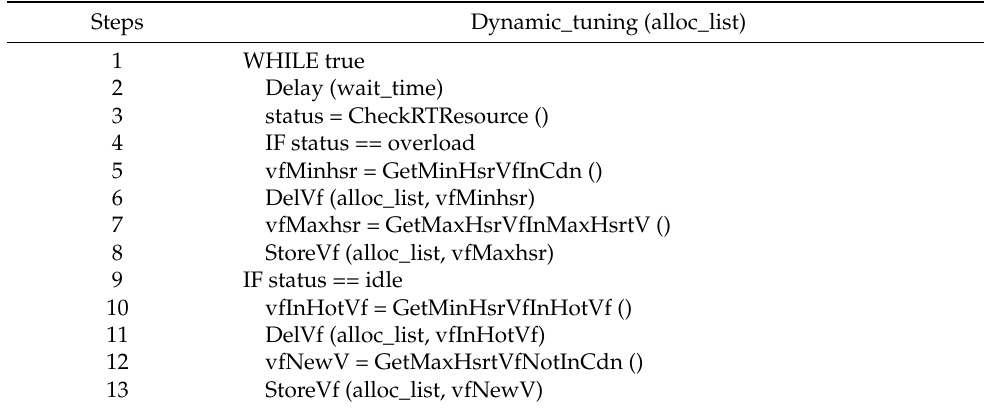
Table 2. Pseudo-code of dynamic adjustment algorithms